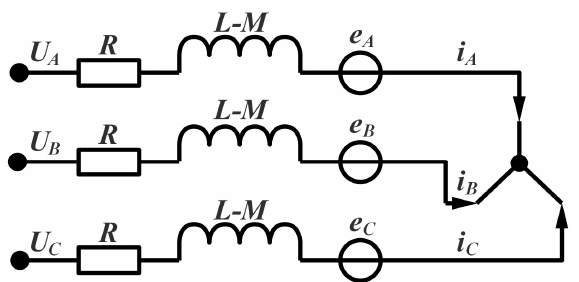
Figure 1. Equivalent circuit of BLDCM.